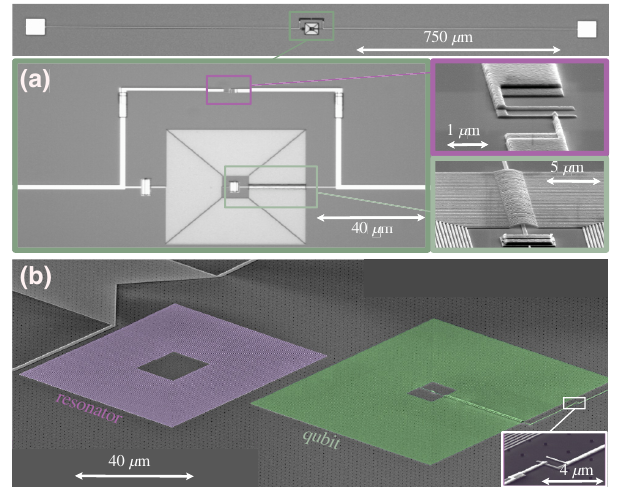
FIG. 2. Qubit designs and fabrication. (a) A SEM image of flux-type qubit G coupled to a three-dimensional (3D) cavity via the coupling antenna (top), which is fabricated from aluminum on high-resistivity silicon. The insets depict the planar coil induc- tor (green frame), with air bridges (bright green frame) and the Josephson junction (purple frame). (b) A false-color SEM image of quasicharge qubit F (green) with a single Josephson junction (inset) coupled to a resonator (purple), which is coupled to a shorted coplanar waveguide (top left). This device is fabricated from aluminum on a HF-vapor-etched silicon-on-insulator (SOI)